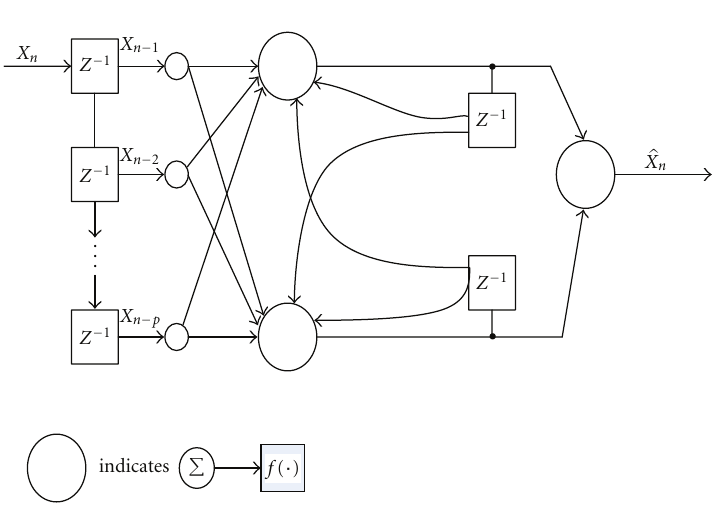
Figure 4: A P -th Elman network